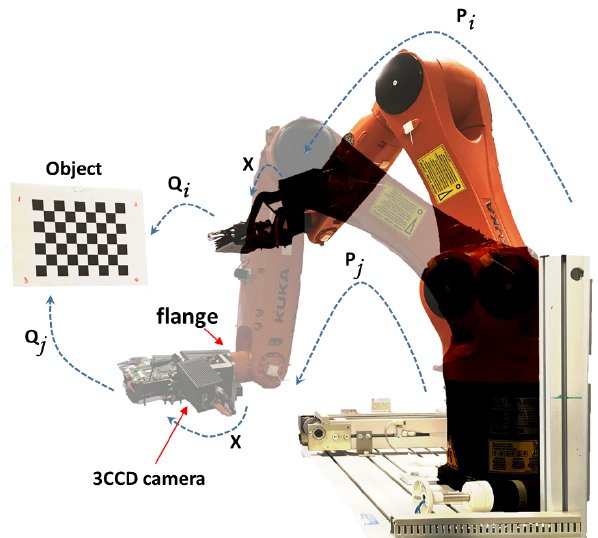
Figure 1. Classical framework for evaluating unknown matrix X for a robotic vision system. The image sensor mounted on flange of multi-axis robot is navigated from position i to j